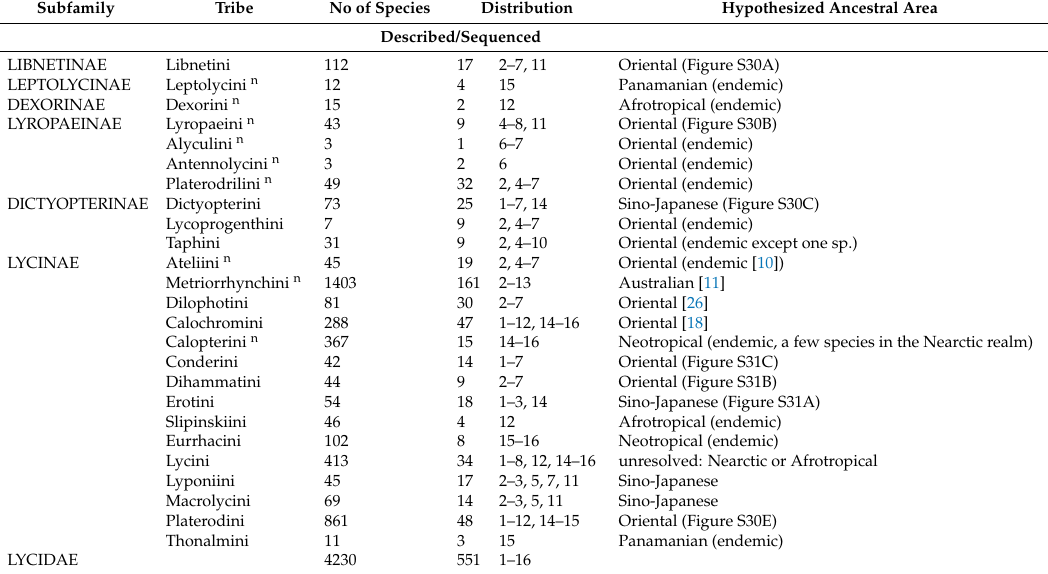
Table 1. Overview of the net-winged beetle classification [14], alpha-taxonomic diversity, number of sequenced samples, distribution and inferred ancestral areas. The recently described tribe rank taxa unavailable for analysis are listed in Table S2. Note: n = the neotenic lineage with proved or supposed larviform females at least in some species. Area codes: 1 Palearctic realm (PAL), western